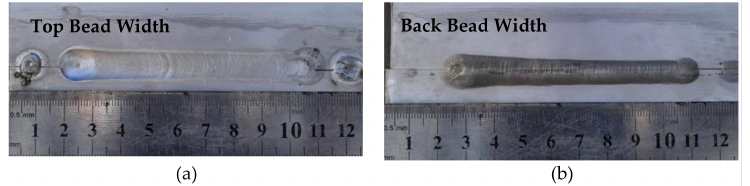
Figure 4. The weld surface profile of continuous wire filling process ( a ) top bead width and ( b ) back bead width.